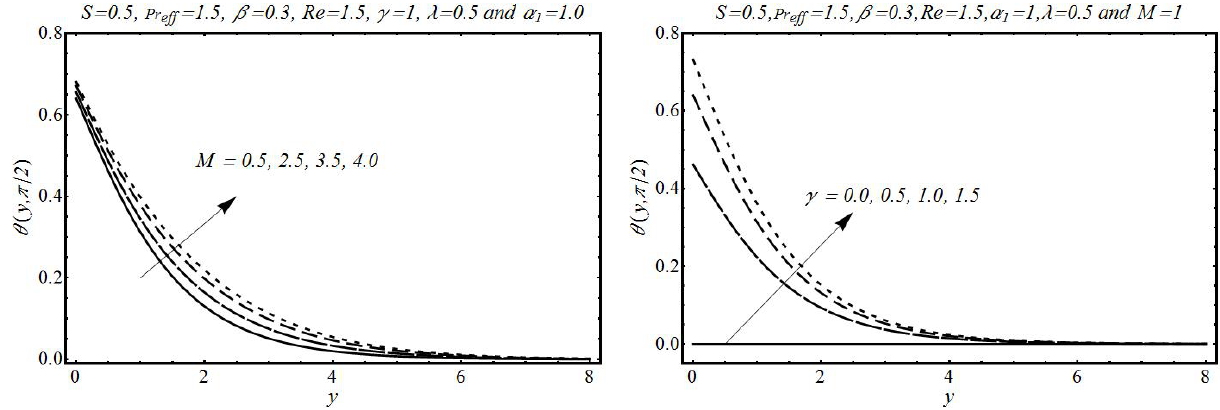
Figure 12: Effects of M on temperature